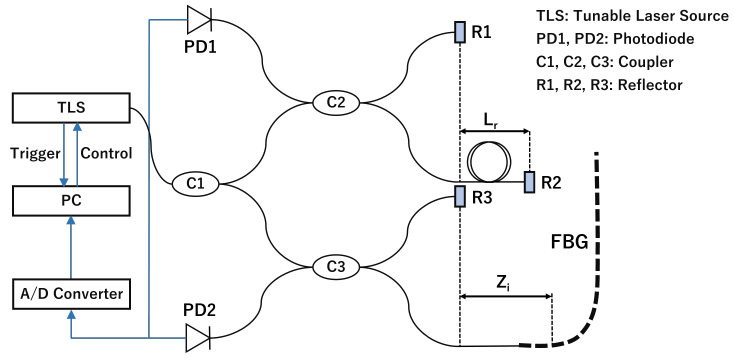
Figure 2. Schematic of the OFDR system used for distribution